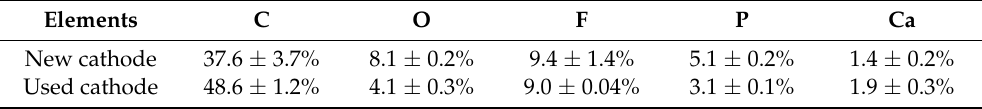
Table 1. Element contents (wt%) of new cathode and used cathode (after 6 months of operation). Elements